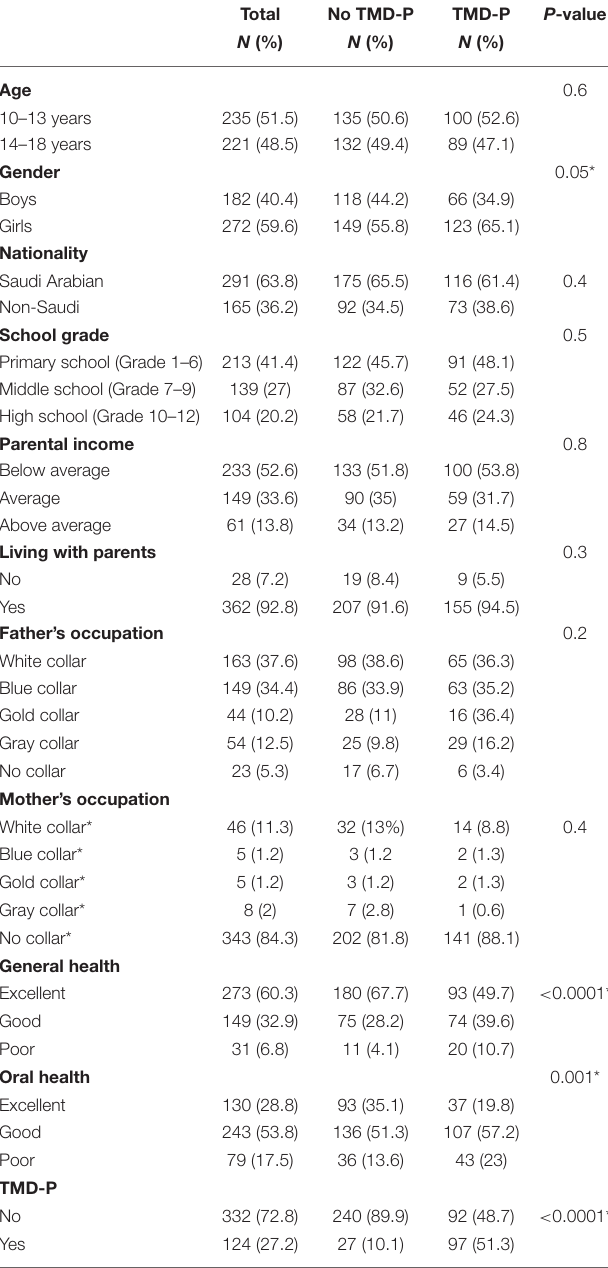
TABLE 1 | Demographic characteristics grouped according to self-reported temporomandibular pain (TMD-P) among adolescents living in Jeddah, Saudi Arabia ( N = 466).